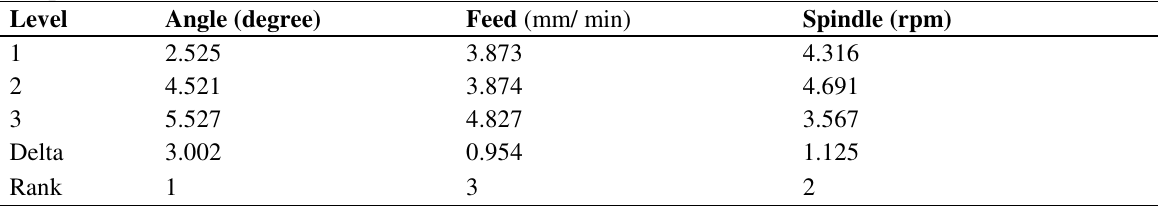
Response table for means for brass.